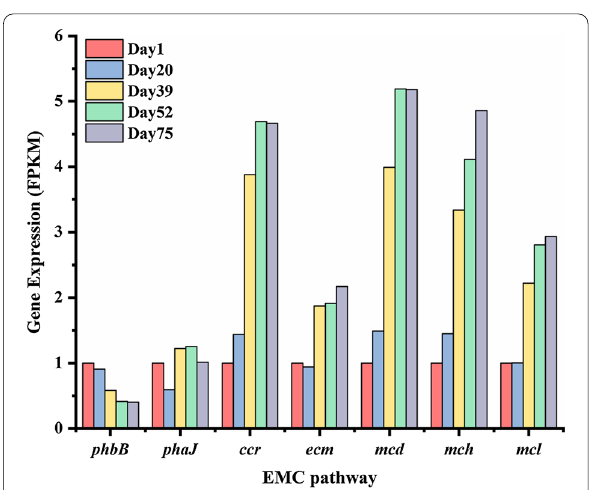
Fig. 7 The changes of the key gene expression in the EMC pathway during the reactor